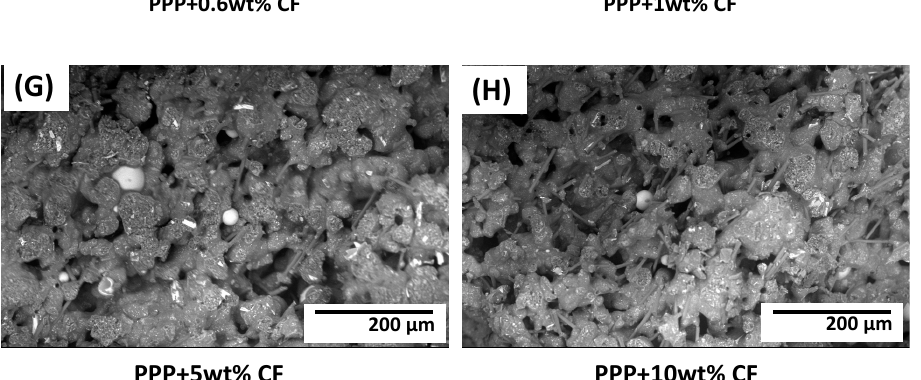
Figure 11. SEM analysis of ( A ) pure PPP, ( B ) short CF, and ( C – H ) fracture surfaces of PPP cured samples with di ff erent amounts of CF.